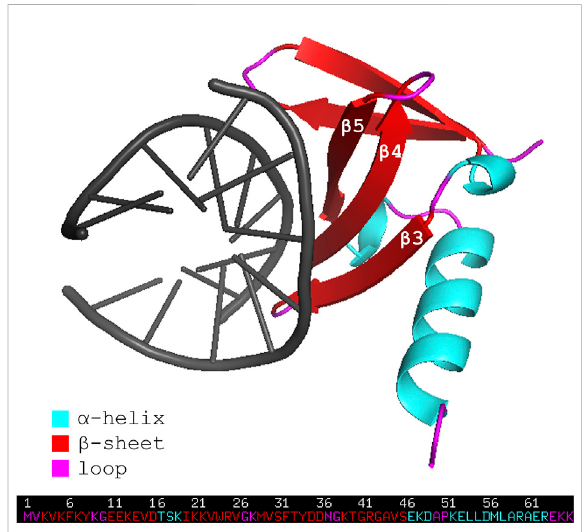
FIGURE 1 Representation of the wild-type af fi tin Sac7d bound to DNA duplex d(GTAATTTAC) 2 (PDB code: 1AZQ). Af fi tin residues are colored following the secondary structure assignment, as shown in the legend. DNA is shown in